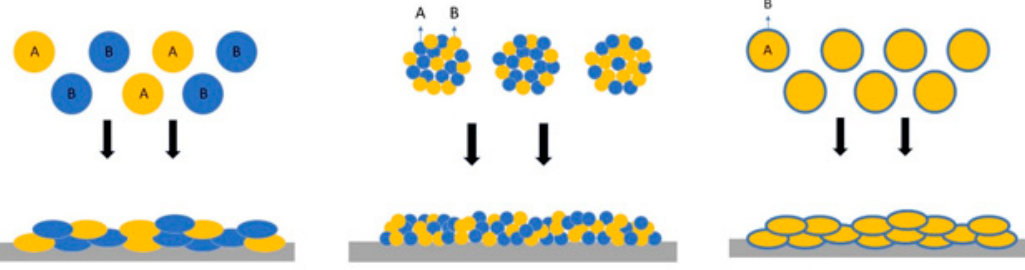
Figure 10. Methods of powders preparation in composite coatings deposition: mixture of powders ( left ), mechanically blended powders ( middle ), and cladded powders ( right ).